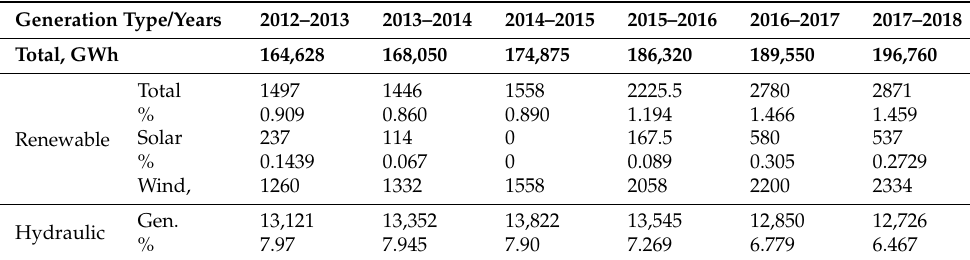
Table 4. Total sold energy on all voltages classified according to uses GWh (2013–2018) [72,73]. Generation